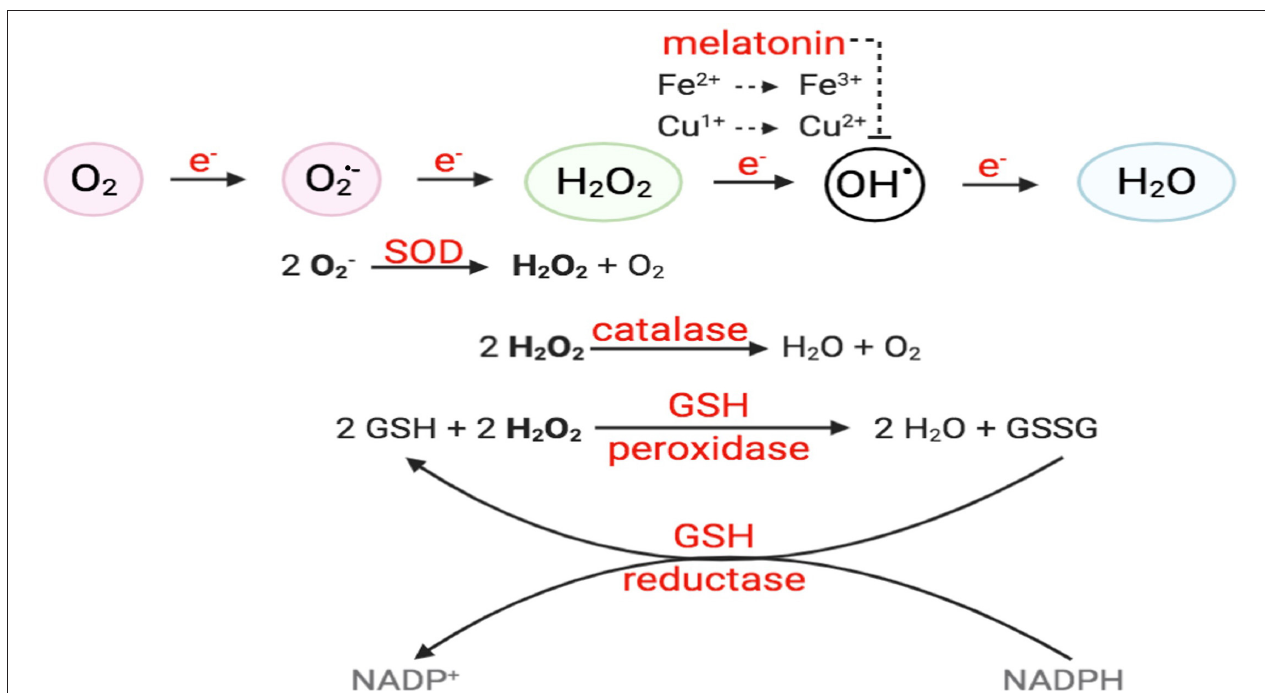
FIGURE 2 | O 2 reduction process and antioxidant enzymes. For O 2 to be fully reduced and stable, it must accept four electrons in the eventual formation of water. Failure to do so results in the generation of free radicals. O 2 with the addition of one electron forms superoxide anion (O •− 2 ); O 2 + two electrons will form hydrogen peroxide (H 2 O 2 ). O 2 + three electrons will form hydroxyl radical ( • OH), in the presence of transition metals, like Fe 2 + and Cu + . Intracellular enzymes that work as antioxidants include SOD, catalase, and GSH peroxidase and reductase. Melatonin has also been shown to decrease hydroxyl radical